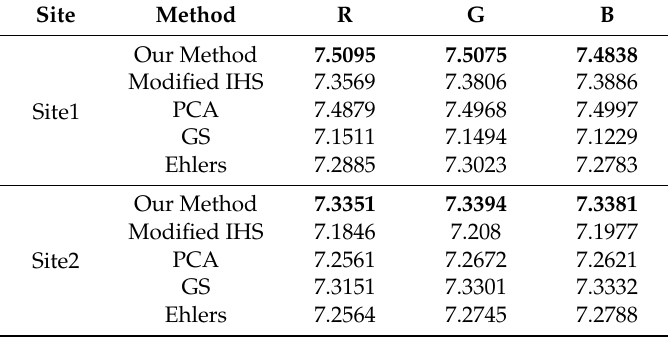
Table 5. Cumulative probability of blur detection (CPBD) between the fused KOMPSAT-5 images and the criterion Landsat-8 OLI